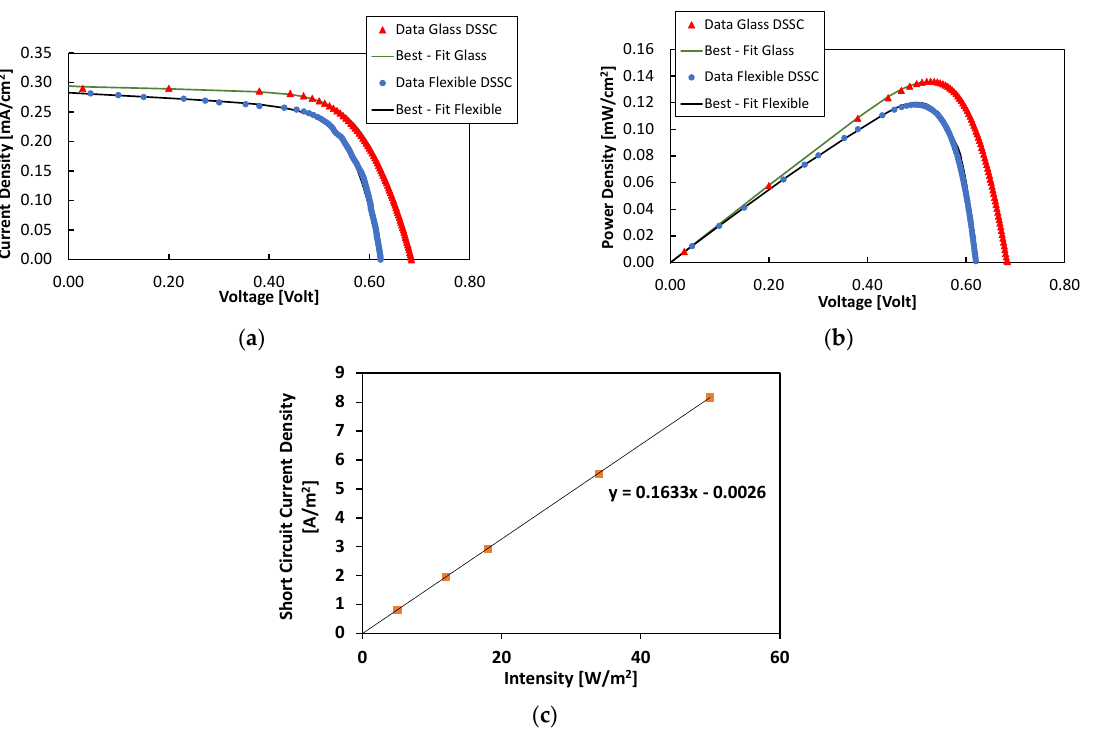
Figure 5. ( a ) I ‐ V and ( b ) P ‐ V characteristics measured under diffuse solar radiation with the flexible and glass DSSCs at an intensity of 18 W/m 2 and 2500 lx. The best fit is obtained using Equation (5) with the parameters given in Table 1. ( c ) Short circuit current density calculated using Equation (3) as a function of the diffuse solar radiation intensity using the spectra shown in Figure 4c. Table 1. Main photovoltaic parameters obtained from DSSC characteristics. GLASS FLEX